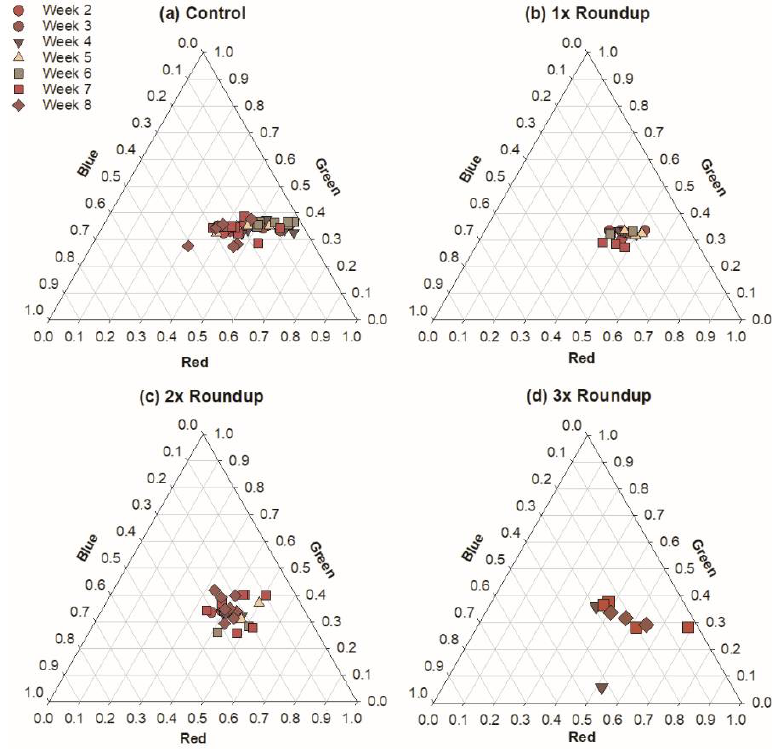
Figure 3. Visible microbial colony colors measured from the pond habitat for each level of Roundup addition. Each axis is a proportion of 255, maximal value for each color.